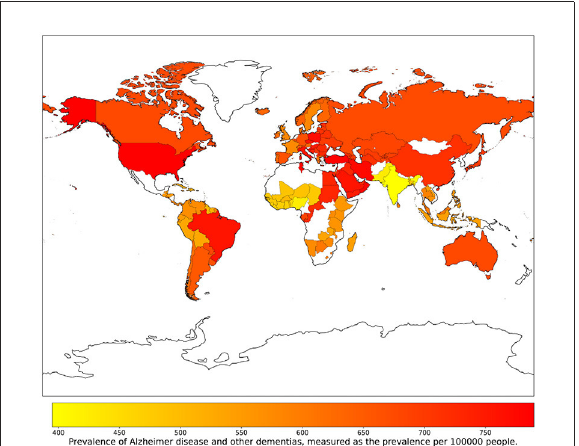
FIGURE1 Prevalence of AD and other forms of dementia (PAD) in 137 UN countries for the year